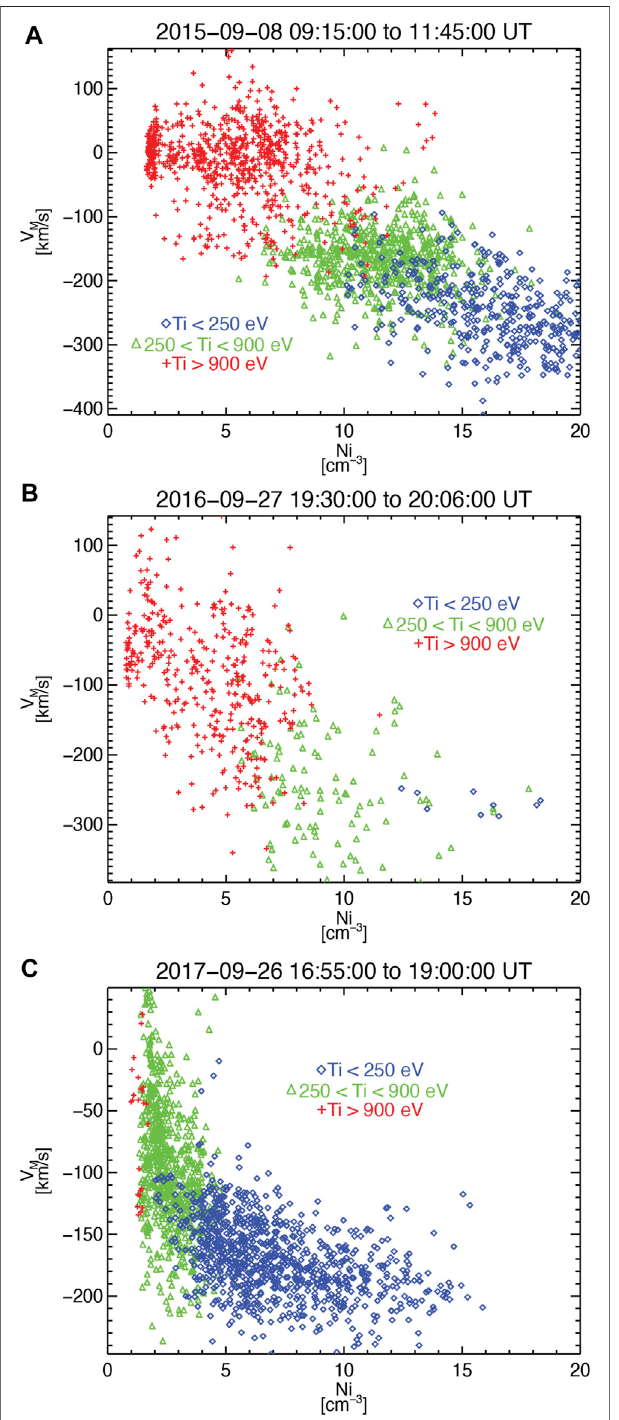
FIGURE 9 | Histograms of SWD bin 1 counts for the three KHI intervals on (A) 2015-09-08, (B) 2016-09-27, and (C) 2017-